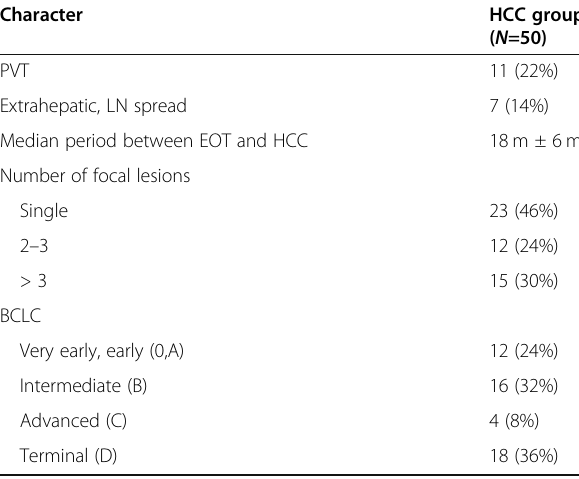
Table 5 Characterization of HCC